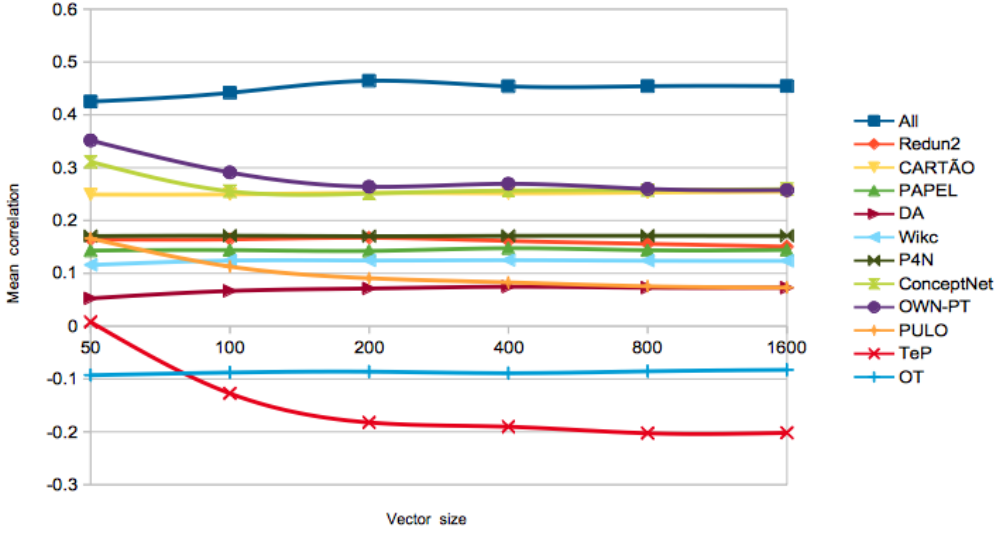
Figure 2. Evolution of ¯ ρ in WordSim-353, for different LKBs, using all relations, with growing vector sizes in